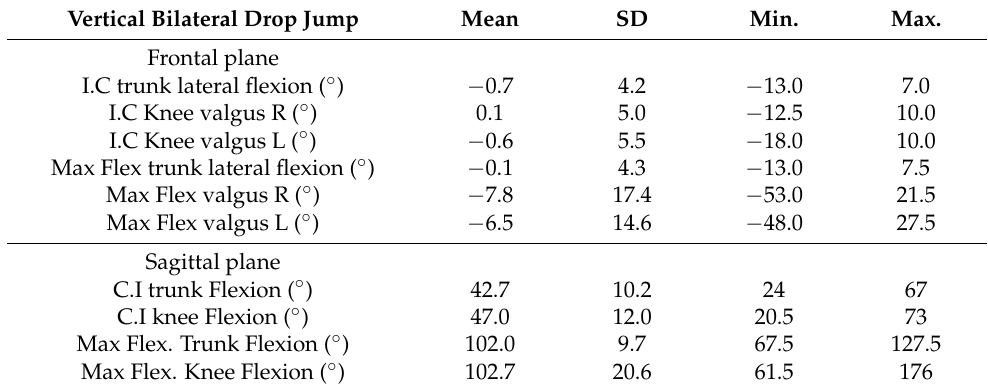
Table 3. Drop Jump Test (bilateral and unilateral) related biomechanical kinematic descriptive values. Vertical Bilateral Drop Jump